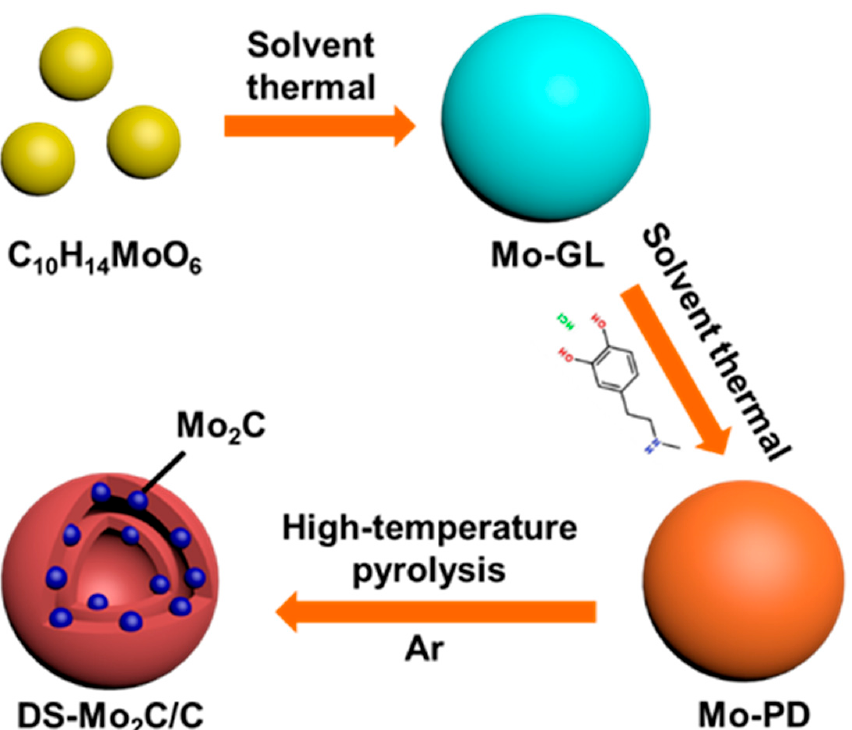
Figure 1. Schematic illustration of preparing DS − Mo 2 C / C microsphere.